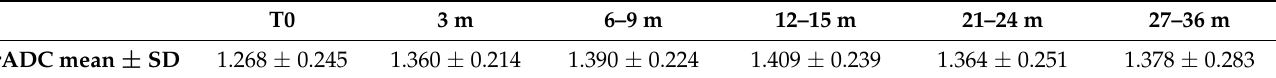
Table 2. The mean values of the rADCm at baseline (T0), 3, 6–9, 12–15, and 21–36 months in the overall group. A progressive and significant increase of rADCm values was detected at each time-point if compared to T0 rADCm ( p < 0.05).